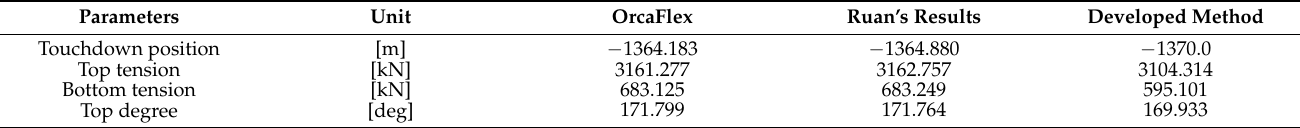
Figure 25. Riser configuration results using OrcaFlex, Ruan’s method, and the developed method. Table 2. Comparison of the dynamic analysis of the SLWR. Table 2. Comparison of the dynamic analysis of the SLWR.